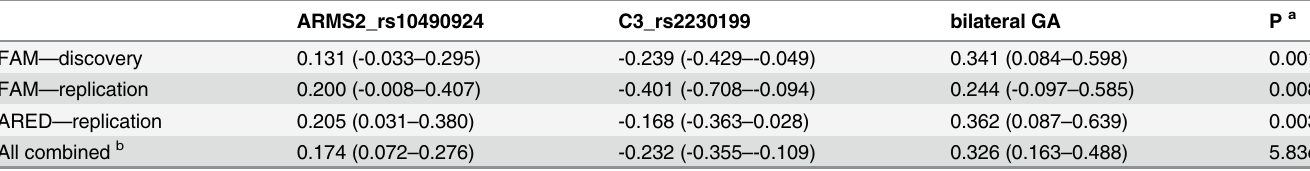
Table 3. Multivariate linear regression analysis of factors significantly correlated to GA